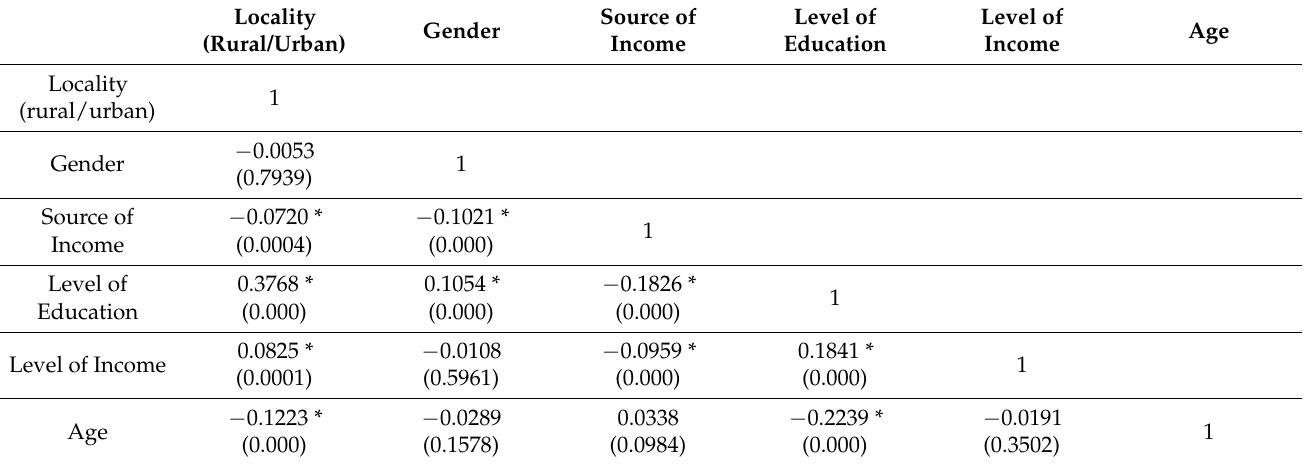
Table A1. Spearman’s correlations between the explanatory